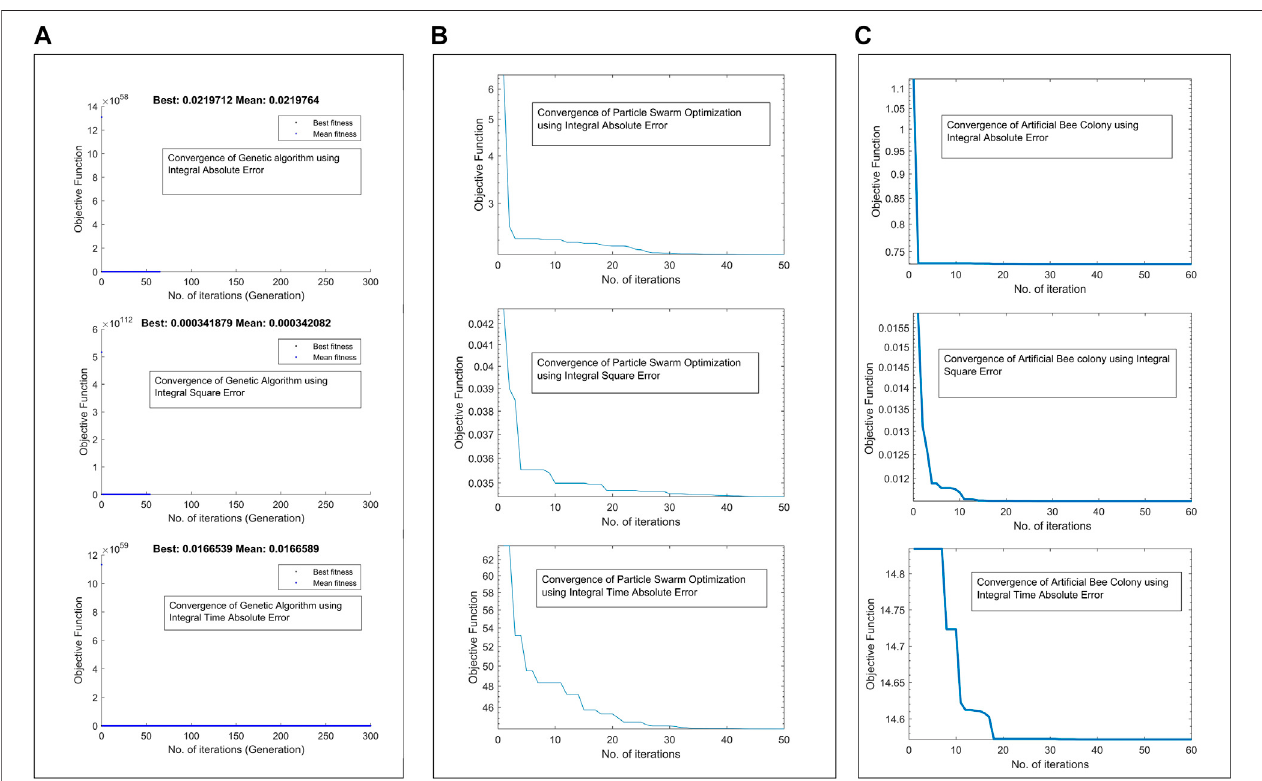
FIGURE 4 | Convergence characteristics of optimization techniques (A) GA (B) PSO (C)